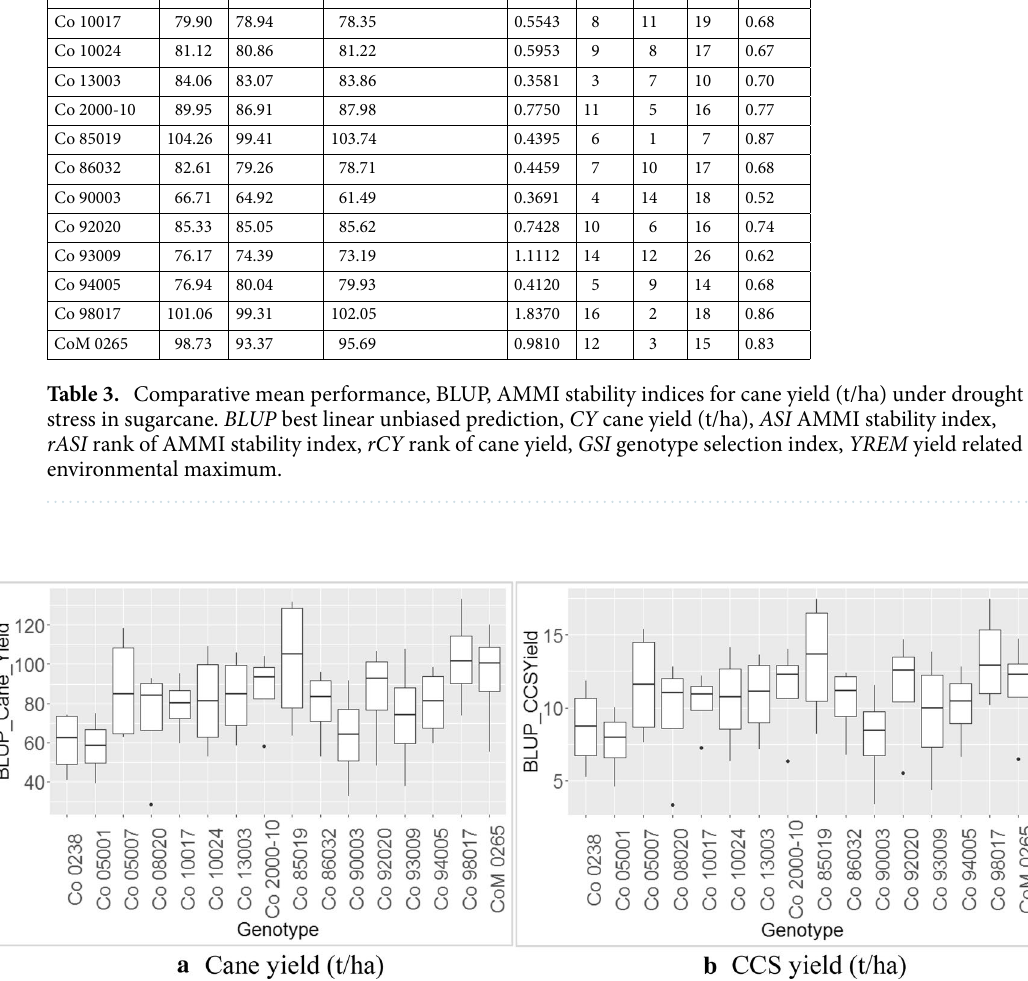
Figure 1. Box plot depicting the multi-environment BLUP based performance for cane yield and CCS yield under tillering phase drought stress of sugarcane genotypes across locations . (a ) Multi-environment BLUP depicting the superior performance of Co 85019 for cane yield under tillering phase drought stress, ( b ) Multi- environment BLUP depicting the superior performance of Co 85019 for CCS yield (t/ha) under tillering phase drought